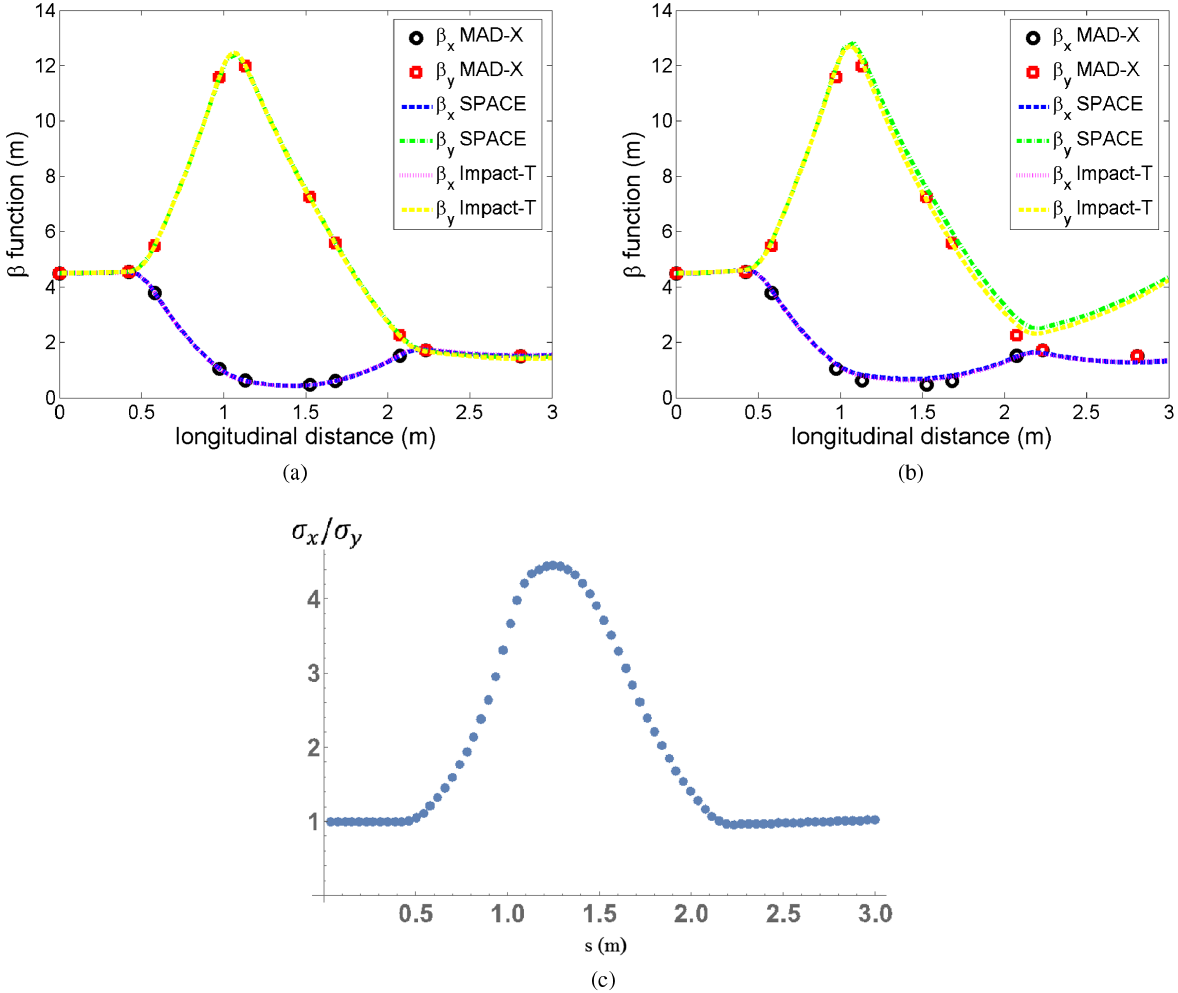
FIG. 11. (a) Evolution of β -functions in the modulator section obtained by MAD - X code (red dots and black dots), SPACE with the space charge turned off (blue and green dash-lines), and I MPACT -Twith the space charge turned off (magenta and yellow dash-lines). (b) Same as in (a), but the space charge was turned on in both SPACE and I MPACT -T codes. (c) Ratio between vertical and horizontal beam sizes in the CeC